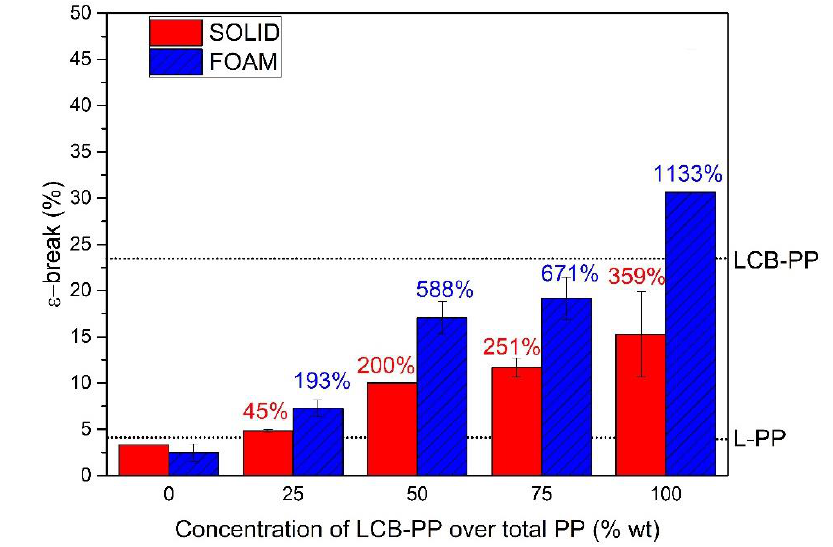
Figure 8. Strain at break of solids samples and foams. The strain at break of the raw used polypropylene is indicated by dotted lines. The percentages in the right graph indicated the percentage of improvement of this sample with respect to the 0% LCB-PP compound value, for solids ( red ) and foams ( blue ).